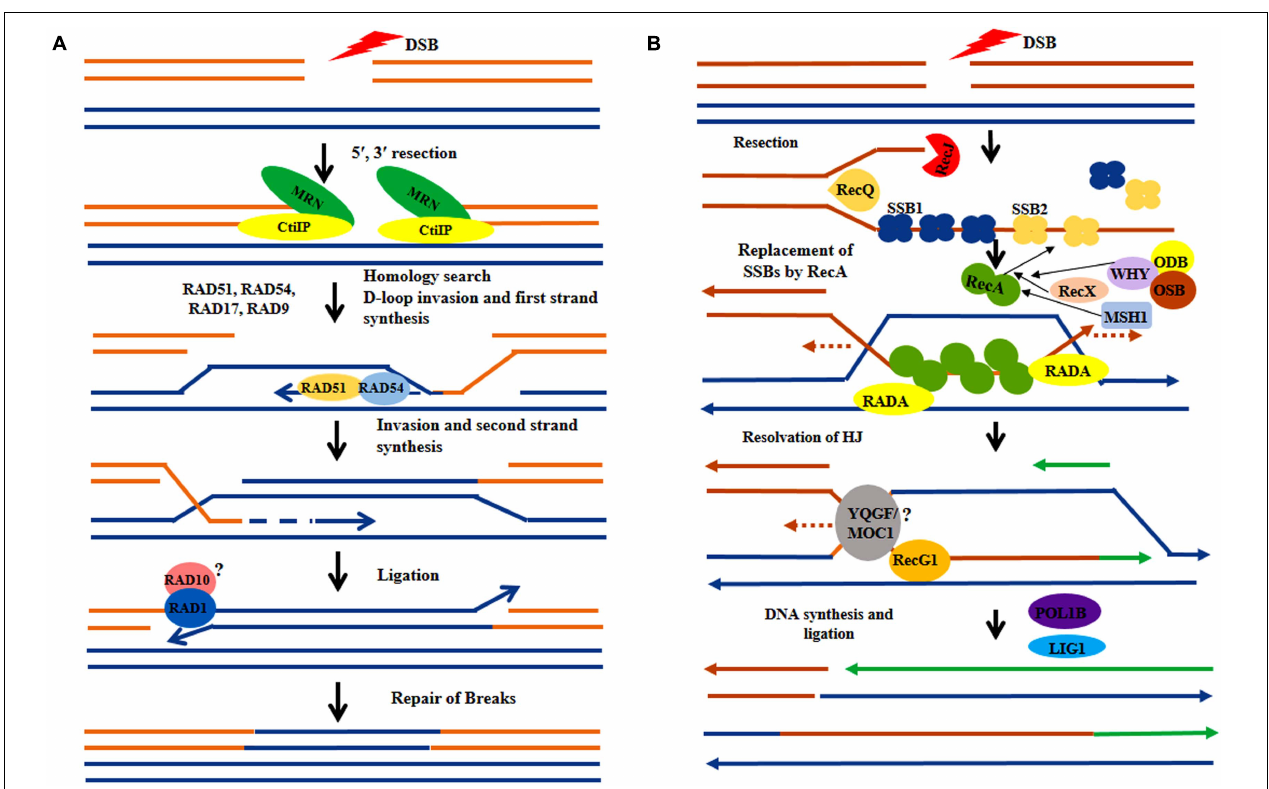
FIGURE 3 | Hypothetical model comparing recombination repair in nucleus and organelles. (A) Following the induction of double-strand breaks (DSBs) in nuclear DNA, the DNA lesions are processed by MRN complex (MRE11, RAD50, NBS1) protein. Then the RAD52 epistatic group of genes plays a crucial role in homology search (RAD54, RAD51) and subsequent strand invasion. The DNA breaks are sealed by the joined action of polymerase and ligase, (B) In the sub-cellular organelles the DSB sites are processed by RecJ and RecQ nuclease proteins followed by subsequent incorporation of nuclear-encoded by Single Strand Binding proteins (SSB1, SSB2). The nuclear-encoded WHIRLY (WHY) family gene along with RecX, ODB, and OSB facilitate incorporation of RecA protein which involves in strand invasion. The uncharacterized proteins, MOC1 and YQGF may be involved in HJ resolution. The ligations of breaks are done by the joined activity of polymerase and